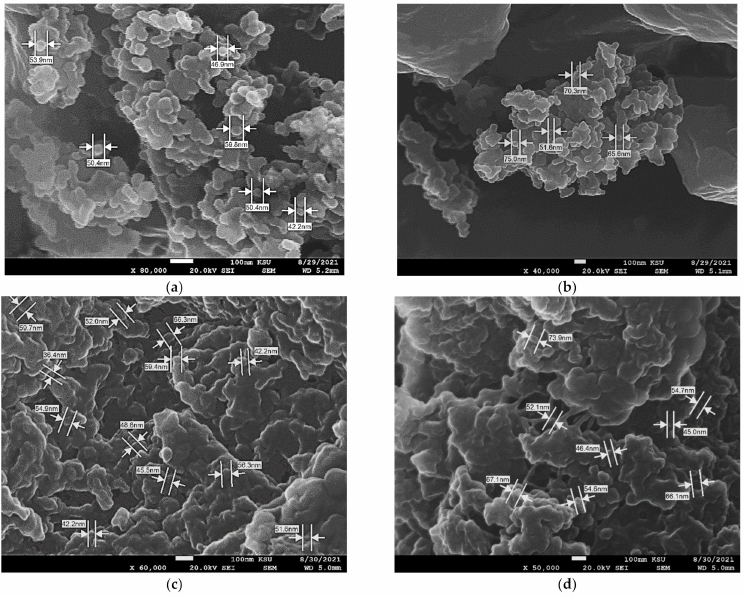
Figure 9. SEM image of (R3 and R4) Complexes, AuNPs and AgNPs with Iod 1 w% ( a ) is R4-AuNPs and ( b ) is R3-AuNPs ( c ) is R4-AgNPs ( d ) is R3-AgNPs Iod 1 w% AgNO 3 2 wt%, gold chloride 3 wt%, and TEA 0.2 wt% dissolved in EGDA 95.6